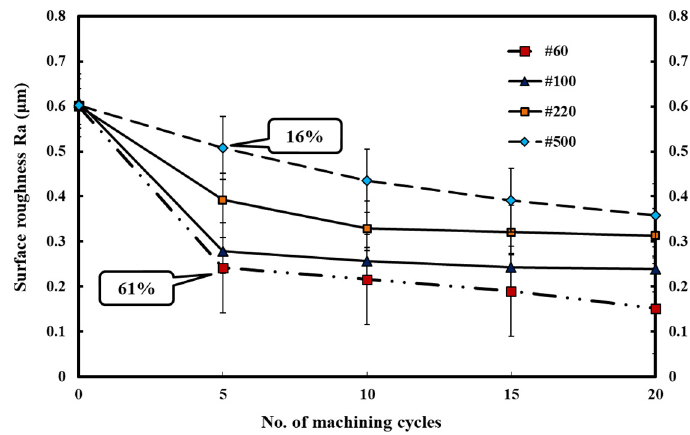
Figure 10. Effects of abrasive mesh size on surface roughness.